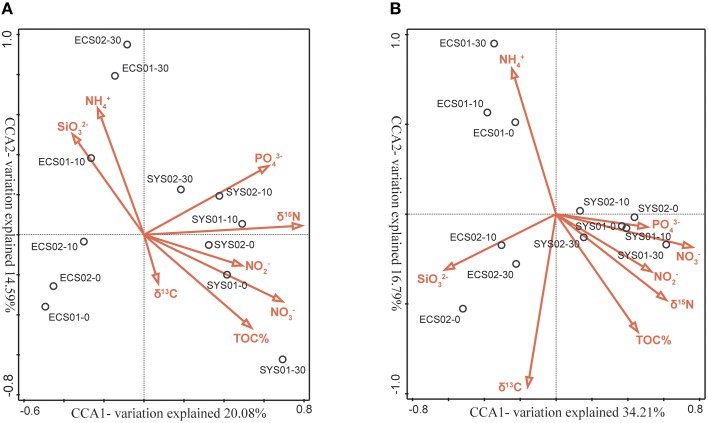
Ordination plots generated by CCA based on the weighted OTU data. The relationship between the AOA (A) and AOB (B)
amoA community compositions in mud deposits of the eastern China marginal seas and environmental parameters were analyzed. Correlations between environmental variables and CCA axes are represented by the lengths and angles of arrows (environmental-factor vectors).